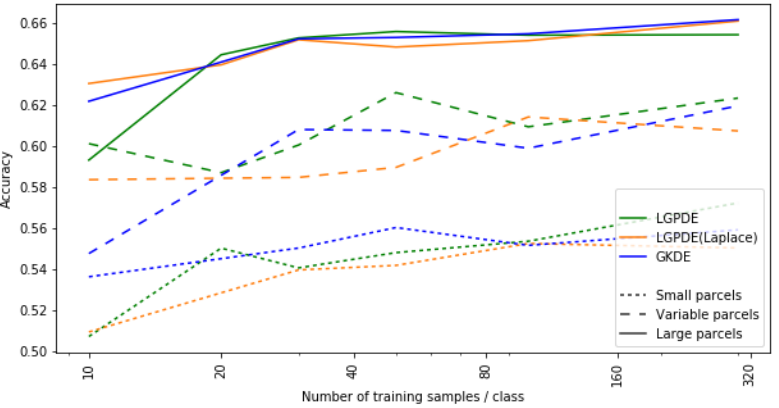
Figure 6. Choice of the discretization bins. ( a ) Accuracy as function of the number of bins for S2 MSI data. ( b ) S1 SAR intensity (sigma nought, σ 0 ) in crop field pixels concentrate within bounds of − 30...0 dB.